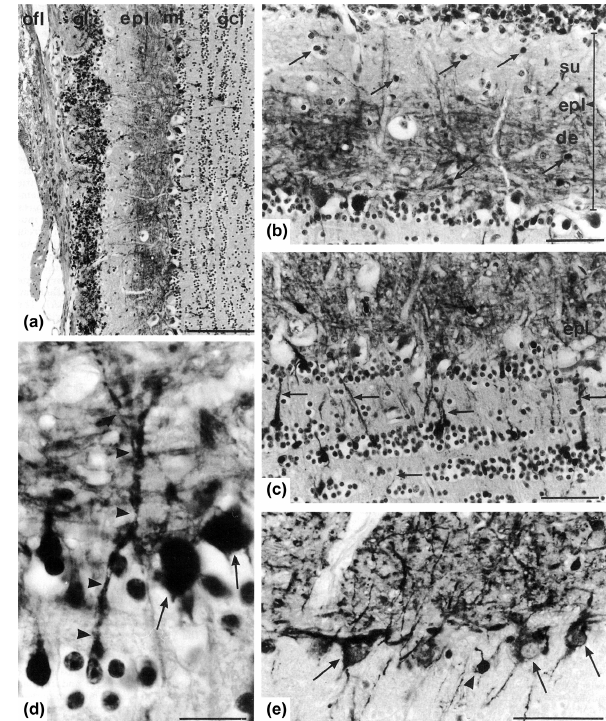
Figure 9. Calretinin immunoreactivity in the main olfactory bulb of adult Tupaia belangeri . (a) Overview: olfactory nerve fiber layer (ofl), glomerular layer (gl), external plexiform layer (epl), mitral cell layer (ml), and granular cell layer (gcl). (b–e) Detailed view of (a) rotated 90 ◦ clockwise. (b) Faint and strong immunoreactivity in the superficial (su) and deep (de) half of the epl, respectively. Arrows, immunopositive neuronal perikarya. (c) Immunoreactive granule cells and their processes (arrows). (d) Immunoreactivity in mitral cells (arrows) and in the dendrite of a granule cell (ar- rowheads). (e) Immunoreactivity in mitral cell somata (arrows) and processes as well as in an inner short axon cell (arrowhead). Scale bars = 150µm in (a) ; 50µm in (b, c, e) ; 15µm in (d) . Reproduced from Malz et al. (2000, Fig. 3). © 2000 Wiley-Liss, Inc., by